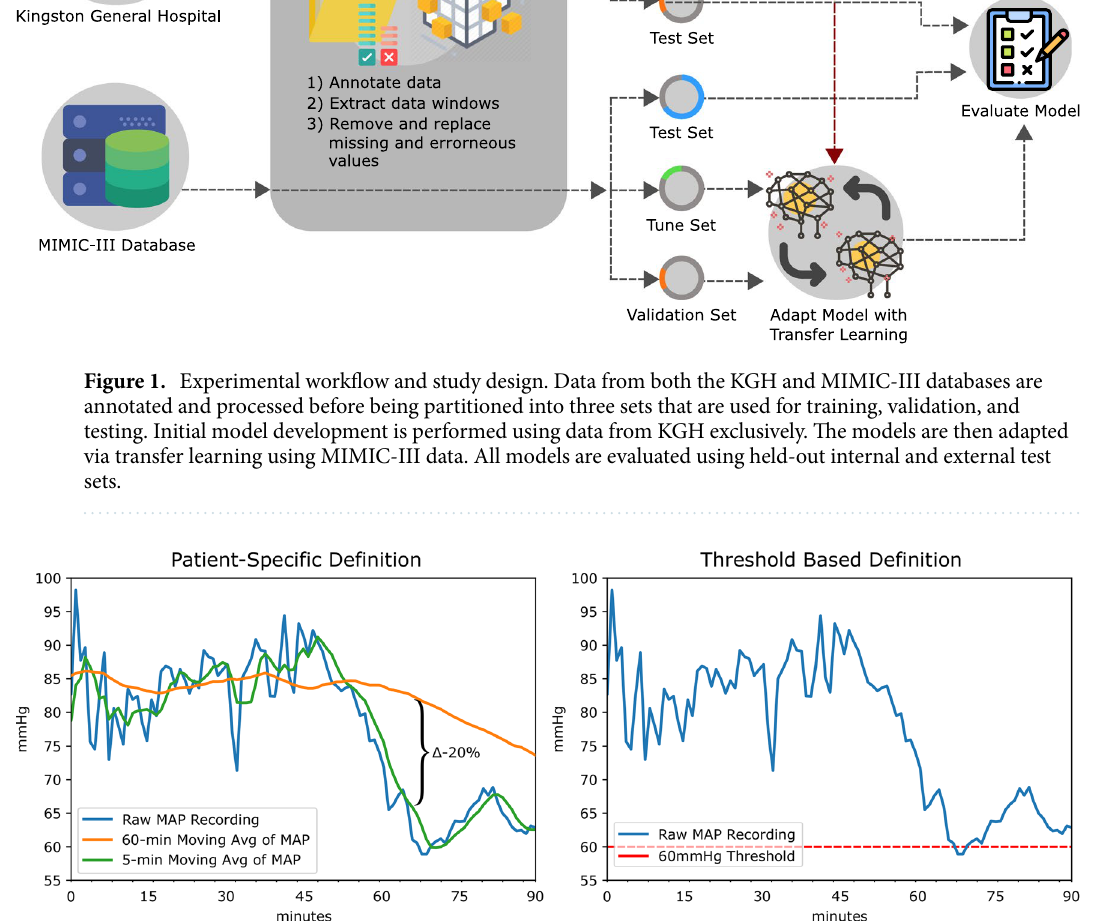
Figure 2. Comparing a patient specific definition (left) of AHE to the threshold based definition (right). Our patient specific definition is based on the use of two moving averages of MAP recordings in which the outcome of interest is a 20% drop in the averages. The conventional definition of AHE is based on a hard threshold such as 60 mmHg as highlighted in red. In this case, the threshold based definition would not annotate an AHE in this patient recording as a MAP below 60 mmHg is not